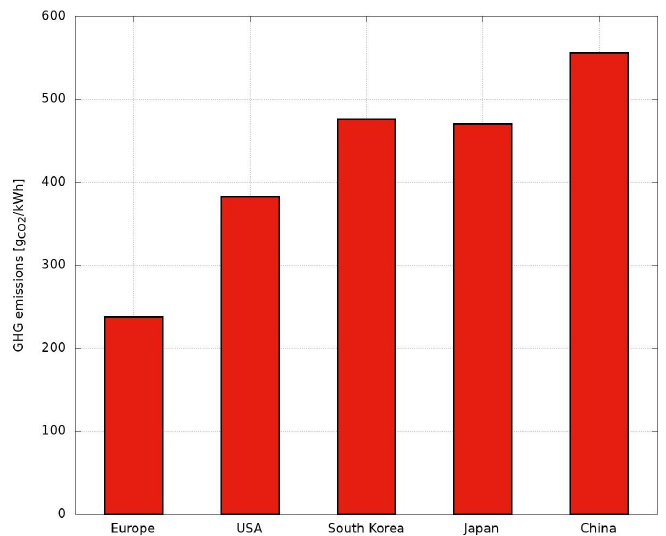
Figure 5. GHG emissions for electricity production in the world (Data source [8]).